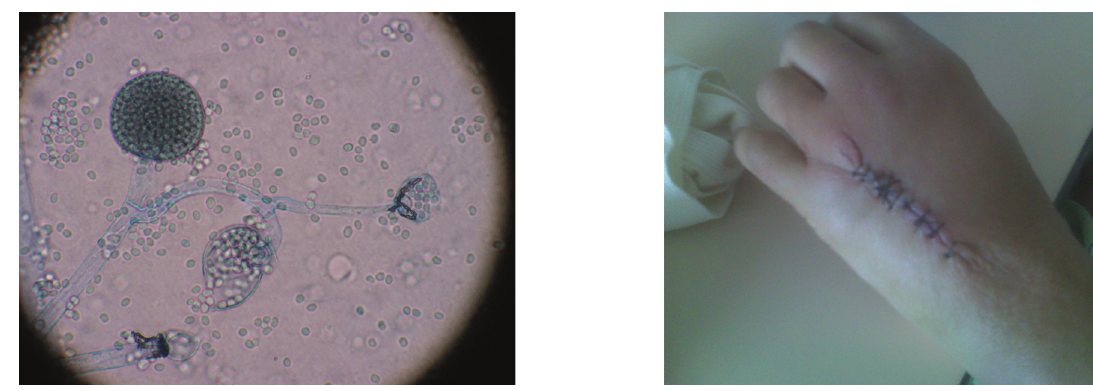
Figure 1: Microscopic sample obtained from patient’s wounds. It shows presence of mucor sp.